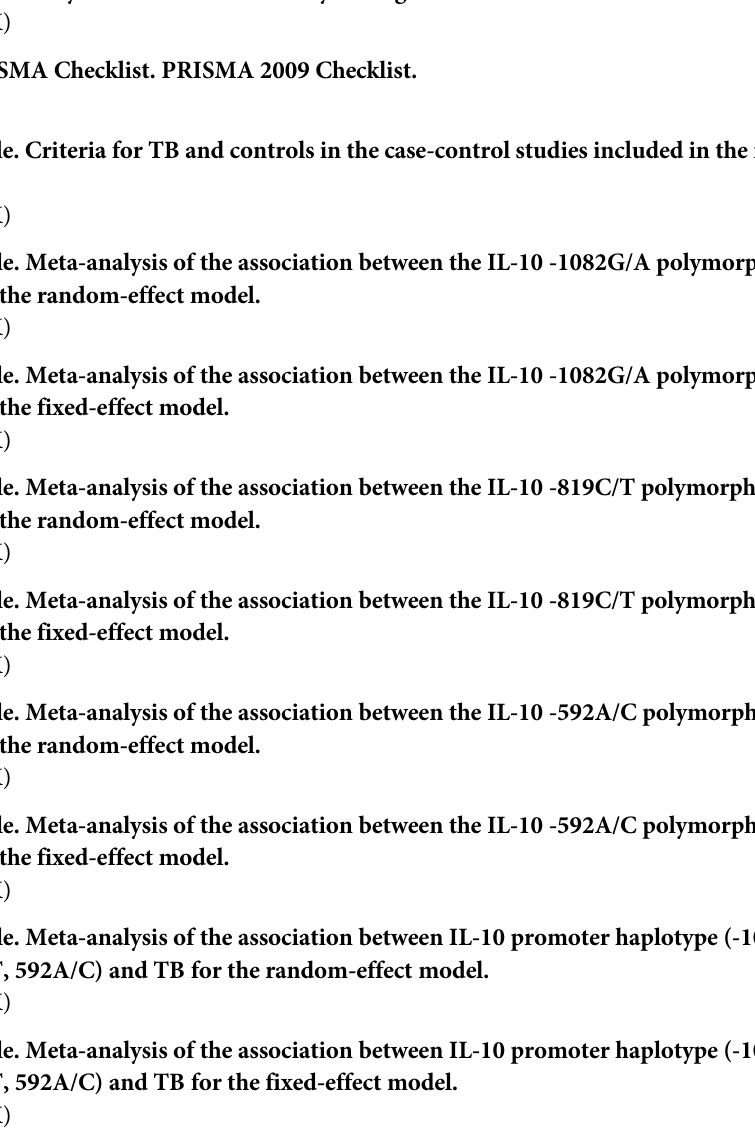
S1 Table. Criteria for TB and controls in the case-control studies included in the meta-anal-